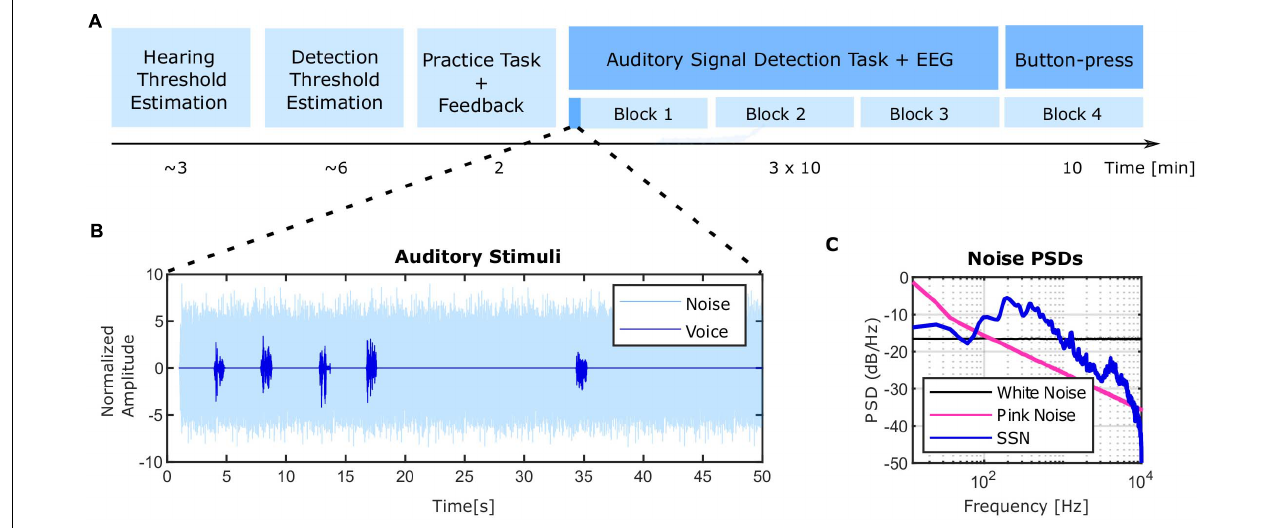
FIGURE 1 | Experimental design and stimuli. (A) Timeline of the experimental session. At the beginning, each individual’s hearing threshold for the masking noise was estimated ( ∼ 3 min). The noise intensity level was set to 40 dB HL and the speech snippet intensity leading to a 70.7% correct detection rate was estimated in the next part ( ∼ 6 min). The speech intensity was set within ± 1.5 dB range of the detection threshold. A short practice task was implemented before the main experiment at which positive feedback was provided for correct detections and negative feedback for missed detections of the stimuli (2 min). Afterward, the main signal detection experiment started which was divided into three blocks with self-paced breaks in between while EEG was recorded. Finally, a subset of subjects took part in an additional task of presseing the button as a control condition (more detailed information can be found in “Materials and Methods” section). (B) The amplitude of speech and noise stimuli over a sample 50 s sub-period of the total block duration. The same ISI pattern was repeated twelve times in the course of each experimental block (10 min). (C) Power spectral density (PSD) of the speech-shaped-noise (SSN) used in the experiment in comparison to white and pink noise. SSN was used as the masking noise in the present